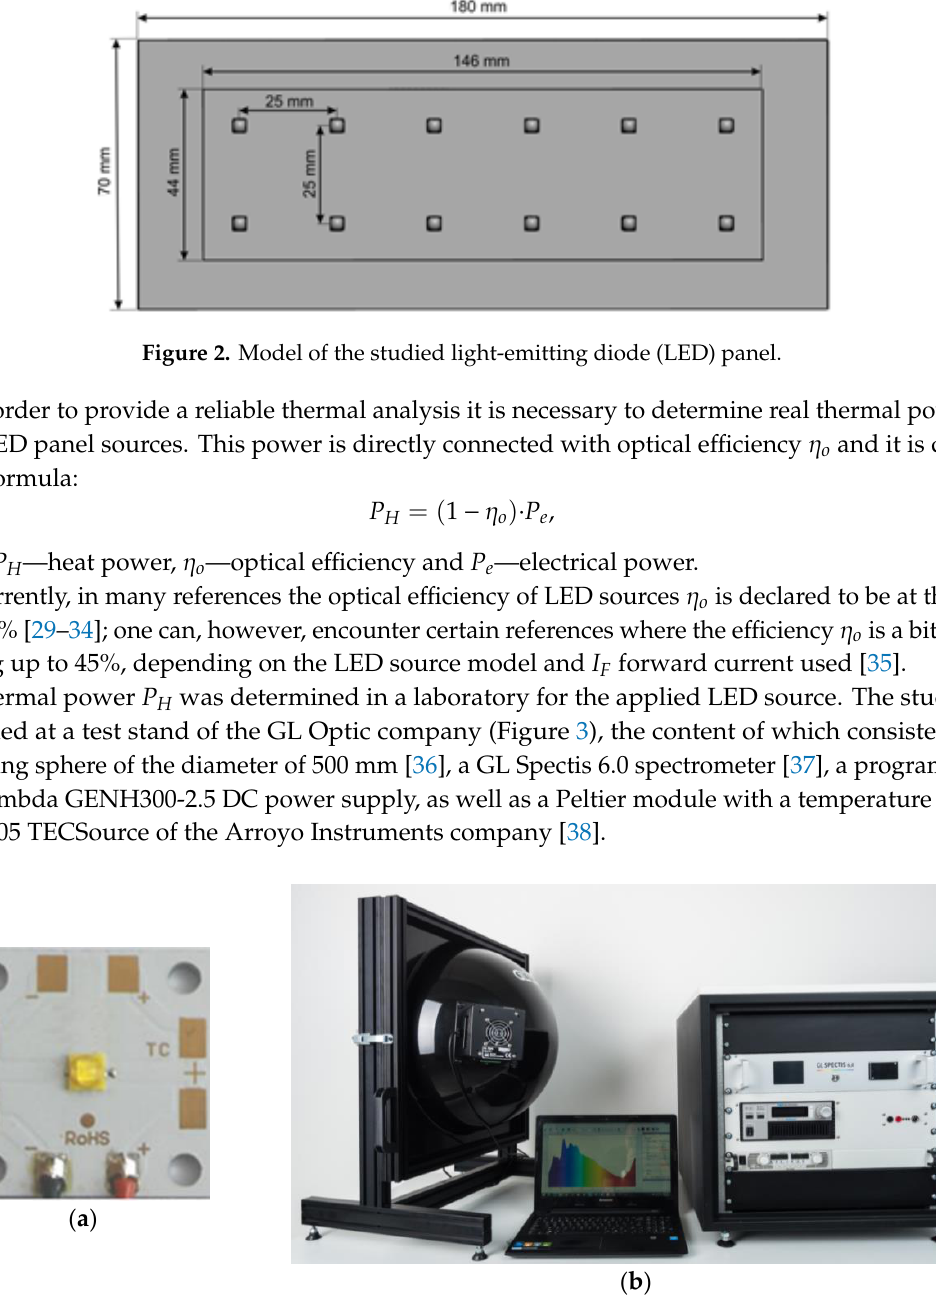
Table 1. Electric power P e , optical power P o , heat power P H and optical efficiency η o for the studied LED source.